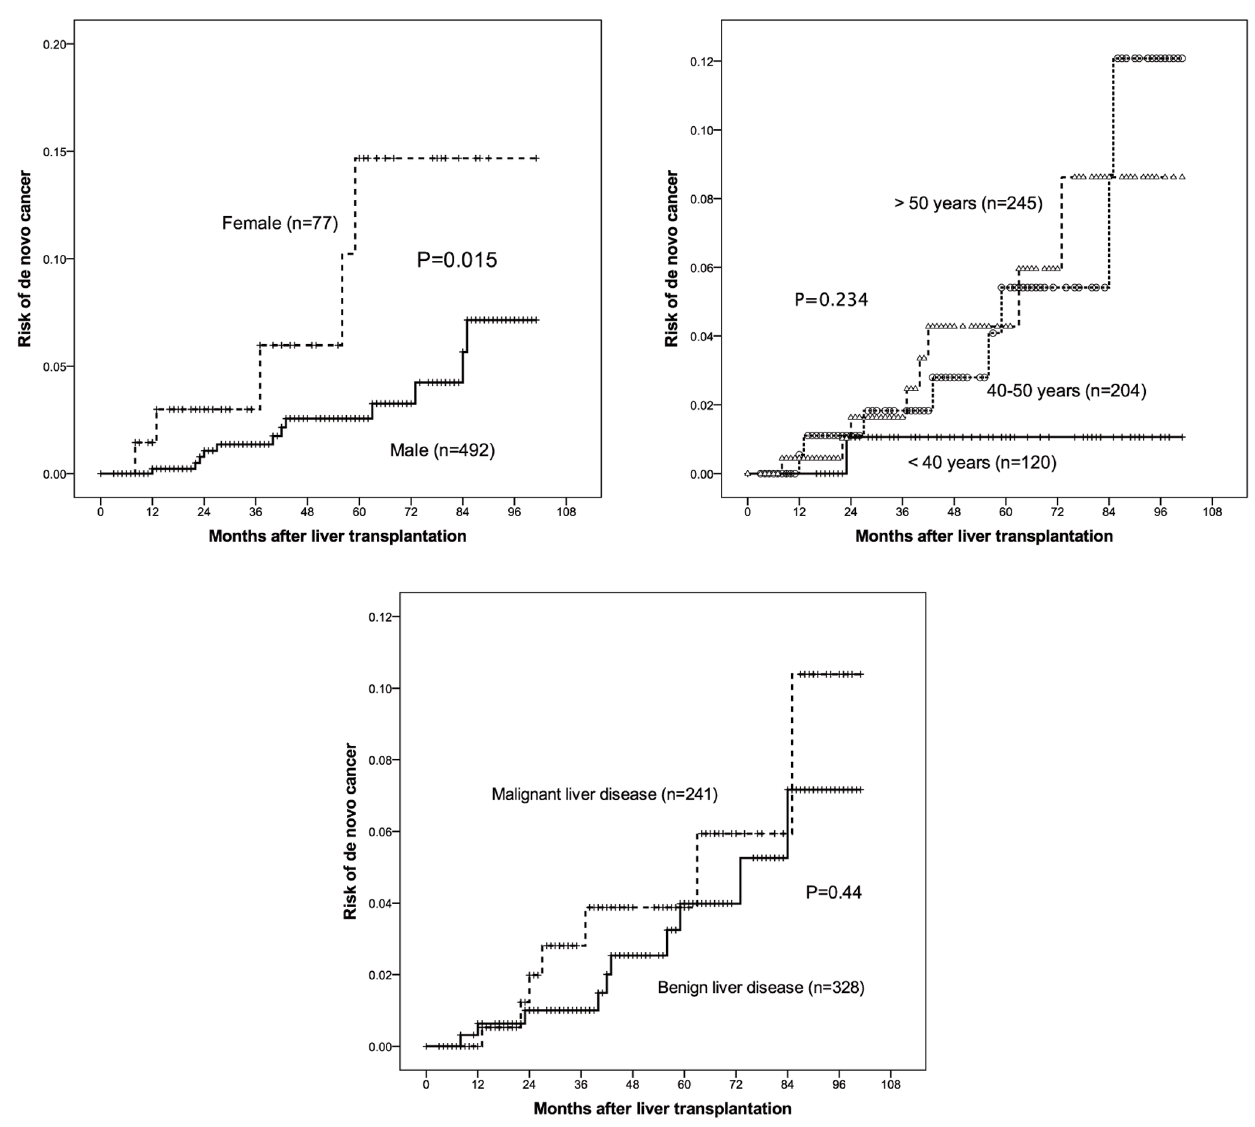
Figure 1. Risk of denovo cancer after liver transplantation in patients survived more than 3 months after transplantation according to their (A) ages, (B) genders and (C) pre-transplant tumor